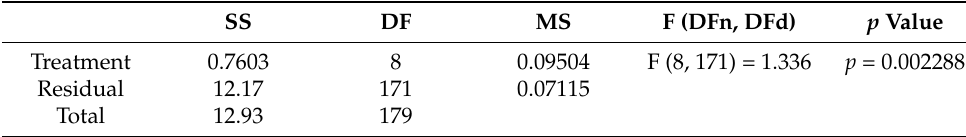
Table 17. ANOVA test analyzing the convergence time. SS DF MS F (DFn, DFd) p Value Treatment